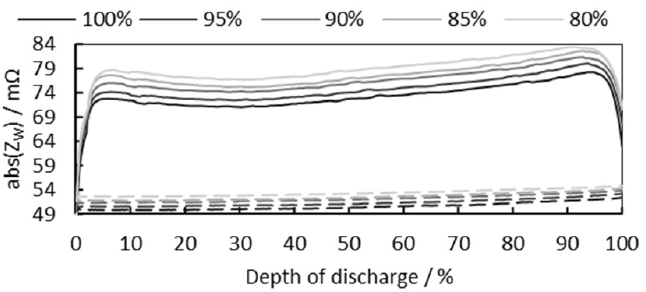
Figure 3. 1 Hz and 1 kHz cell impedance during discharge of cells with different SoHs. The solid lines represent the 1 Hz impedance, the dotted lines represent the 1 kHz impedance, and the different brightness of the line represents the different cell